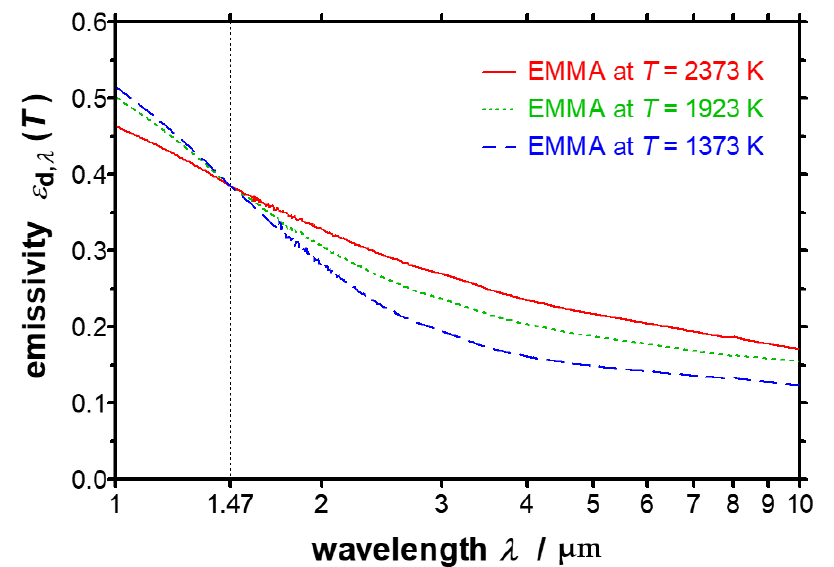
Figure 18. Logarithmic plot of the spectral directional emissivity of tungsten normal to the surface measured with the EMMA at different temperatures between T = 1373 K and T = 2373 K. The X-point is clearly visible at a wavelength of λ X = 1.47 µ